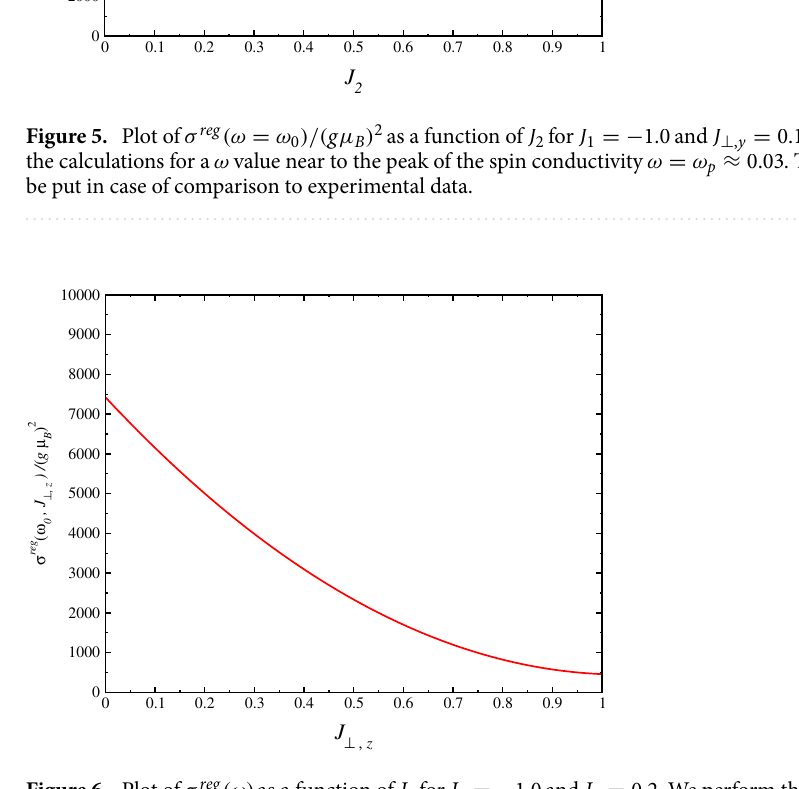
Figure 6. Plot of σ reg (ω) as a function of J z for J 1 ω value near to the peak of the spin conductivity ω comparison to experimental